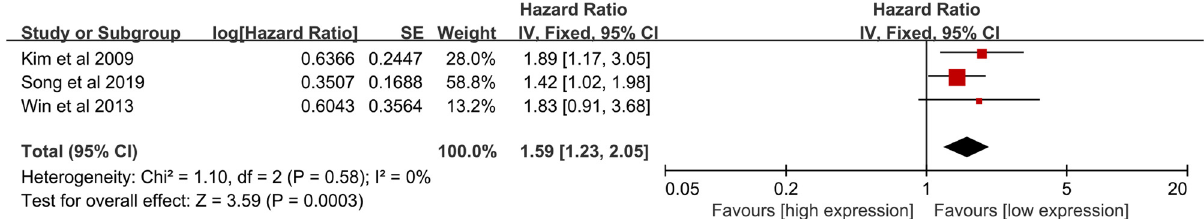
Figure 5: Meta - analysis for the association between NNMT expression and DFS indicated that high NNMT expression was signi fi cantly associated with worse DFS compared to low NNMT expression in cancer